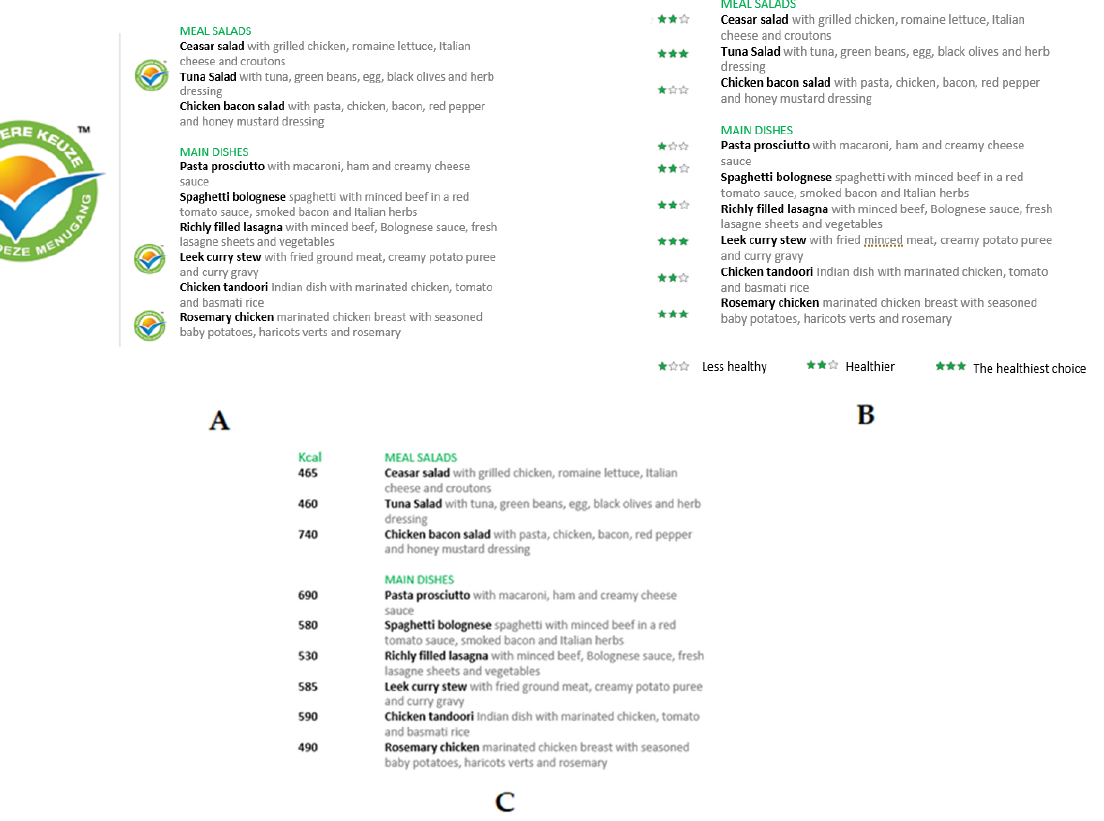
Figure 1. Fictive menu with implemented menu labeling formats: ( A ) simple health logo; ( B ) star ranking; ( C ) calorie information. A dish receives the simple health logo if it complies to all the choices criteria for main dishes. With star ranking the number of stars a dish receives is also established by the compliance to the Choices criteria for main dishes: compliance to all criteria = 3 stars; compliance to all minus max two criteria = 2 stars; compliance to less than two criteria = 1 star. With calorie information the number of calories is calculated based on NEVO data.